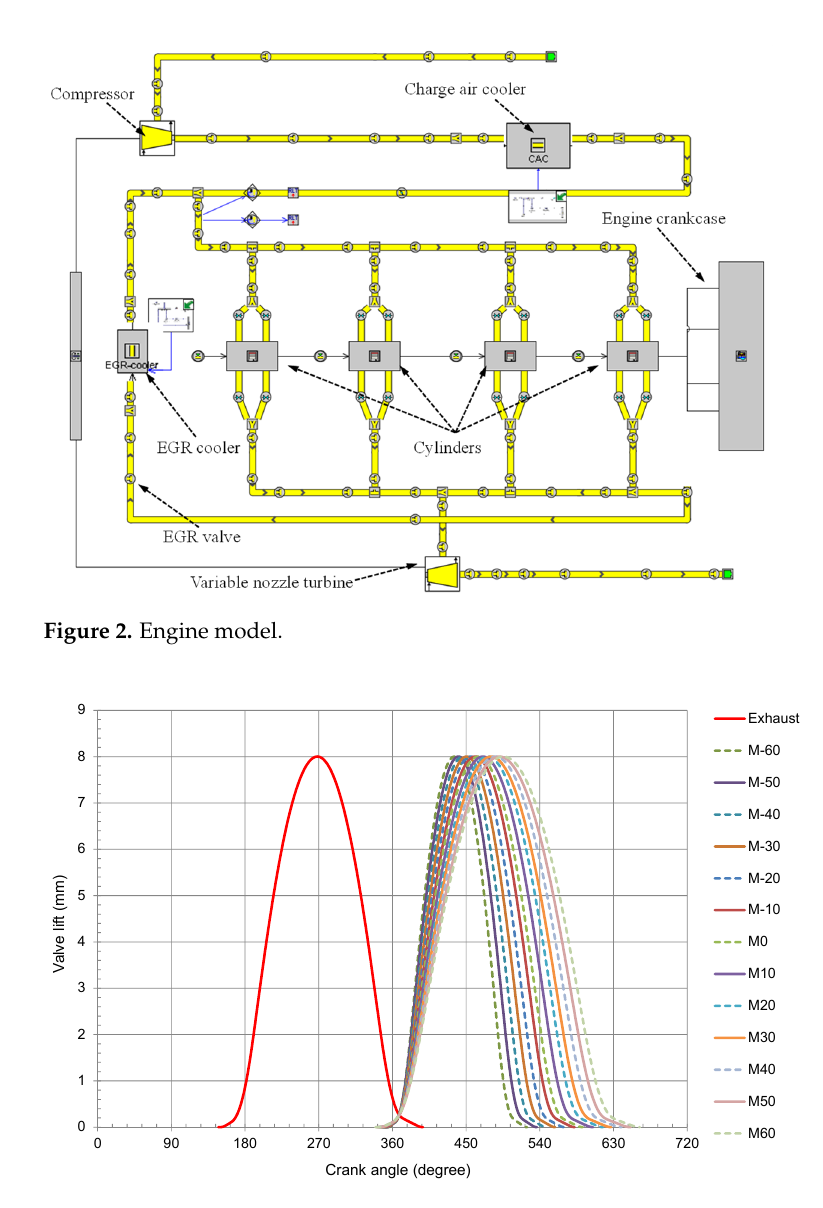
Figure 3. Improved intake valve lift curve of the diesel engine.